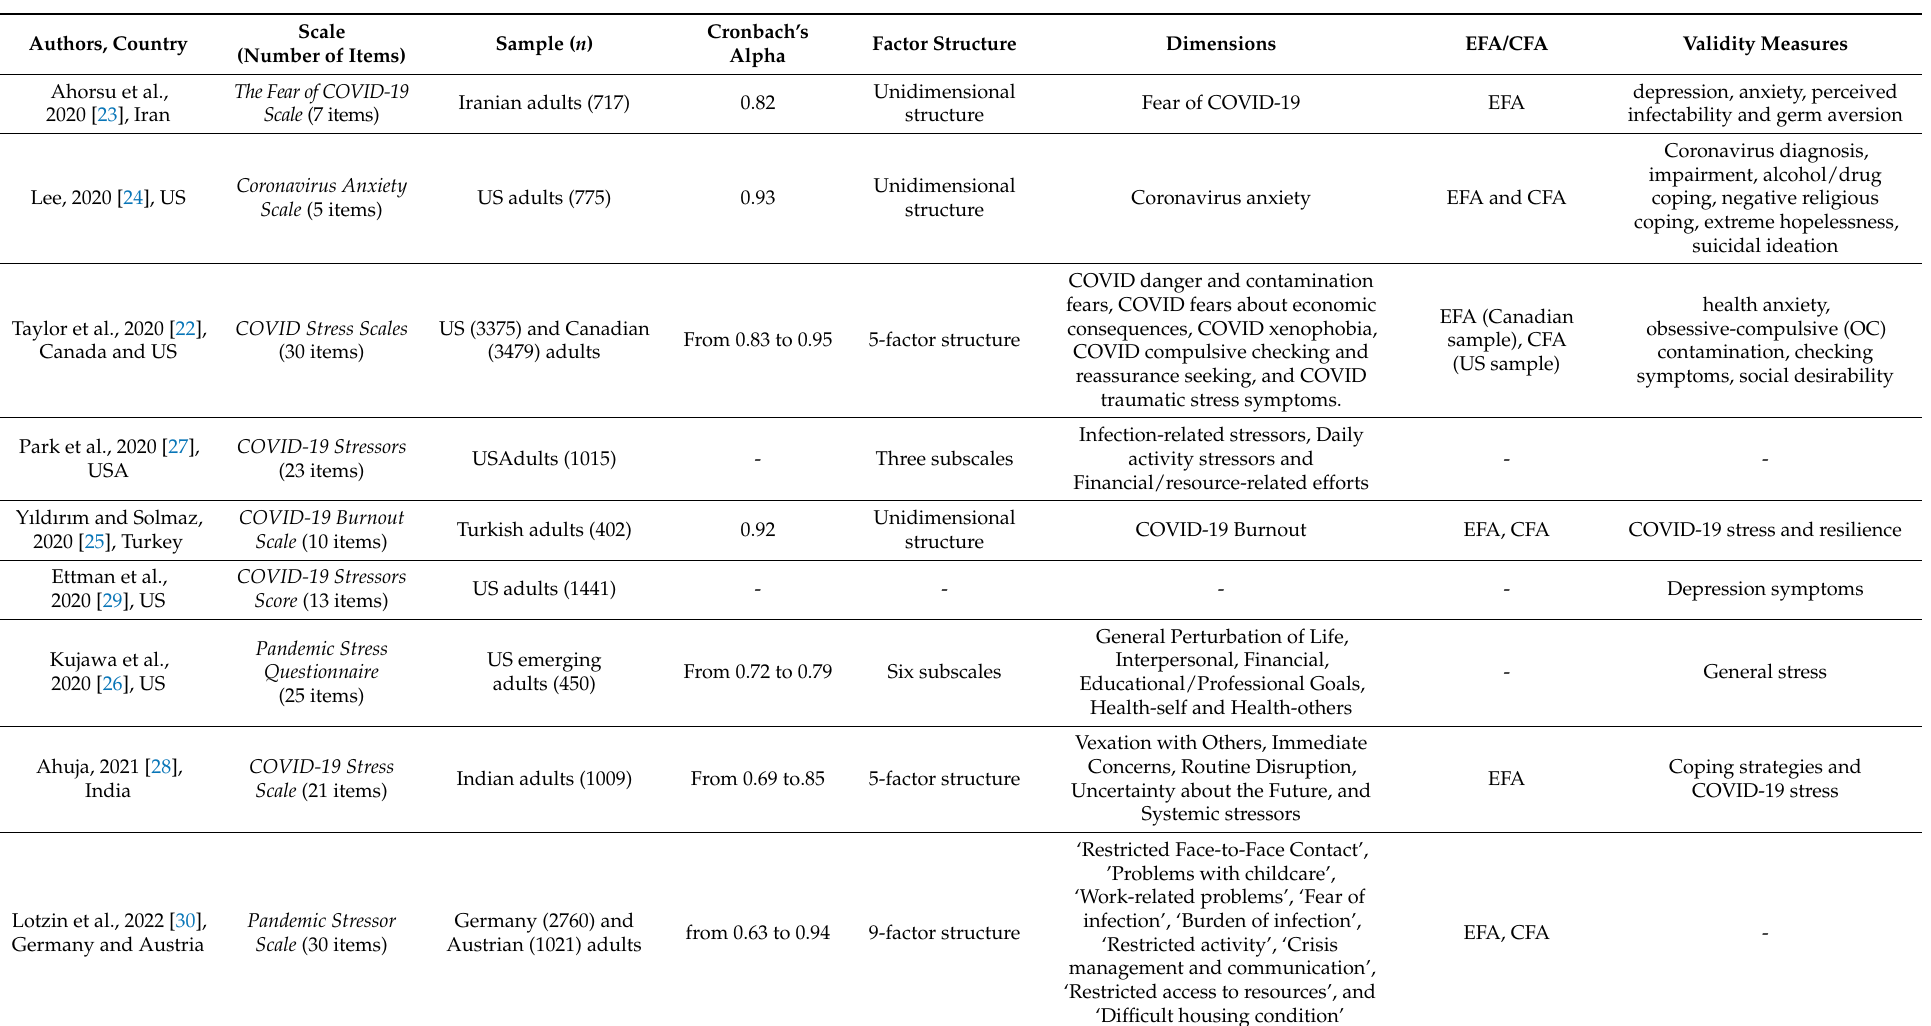
Table 1. Measures of distress, anxiety, sleep problems, or post-traumatic stress symptoms during the COVID-19 pandemic in chronological order of